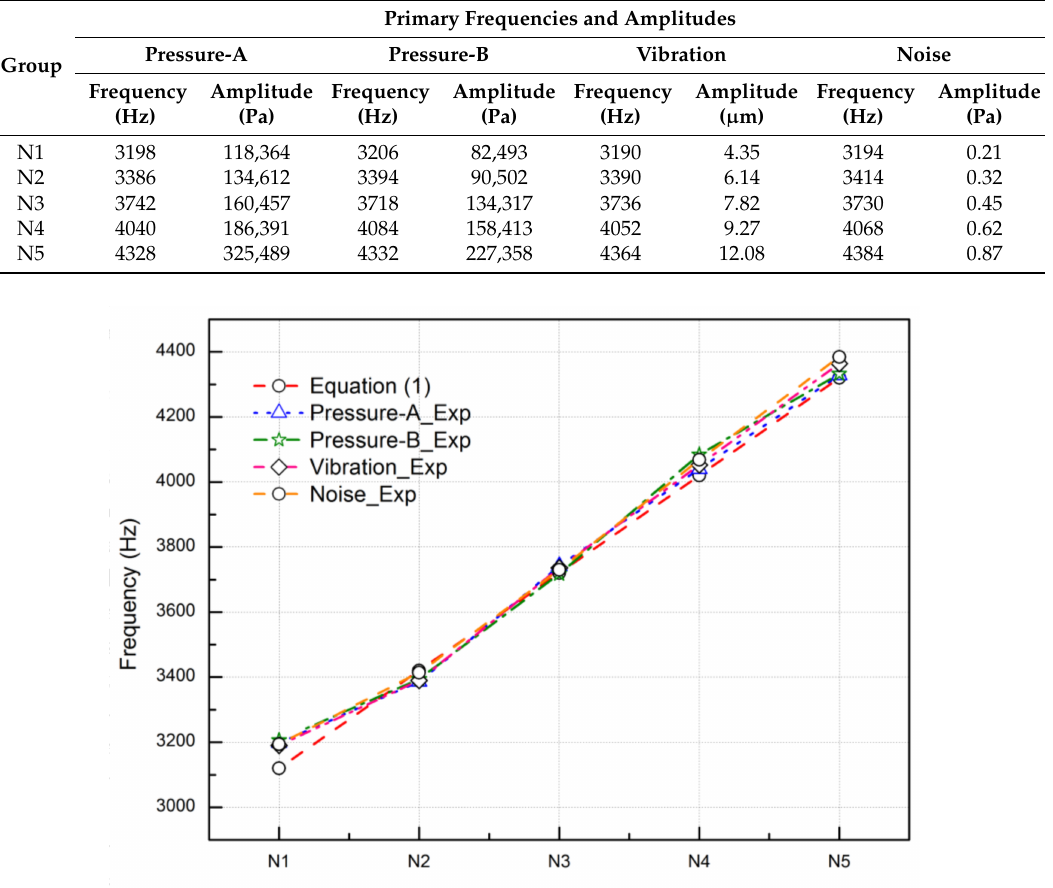
Table 7. Comparison of the experimental results for the Type B flapper-armature assembly.